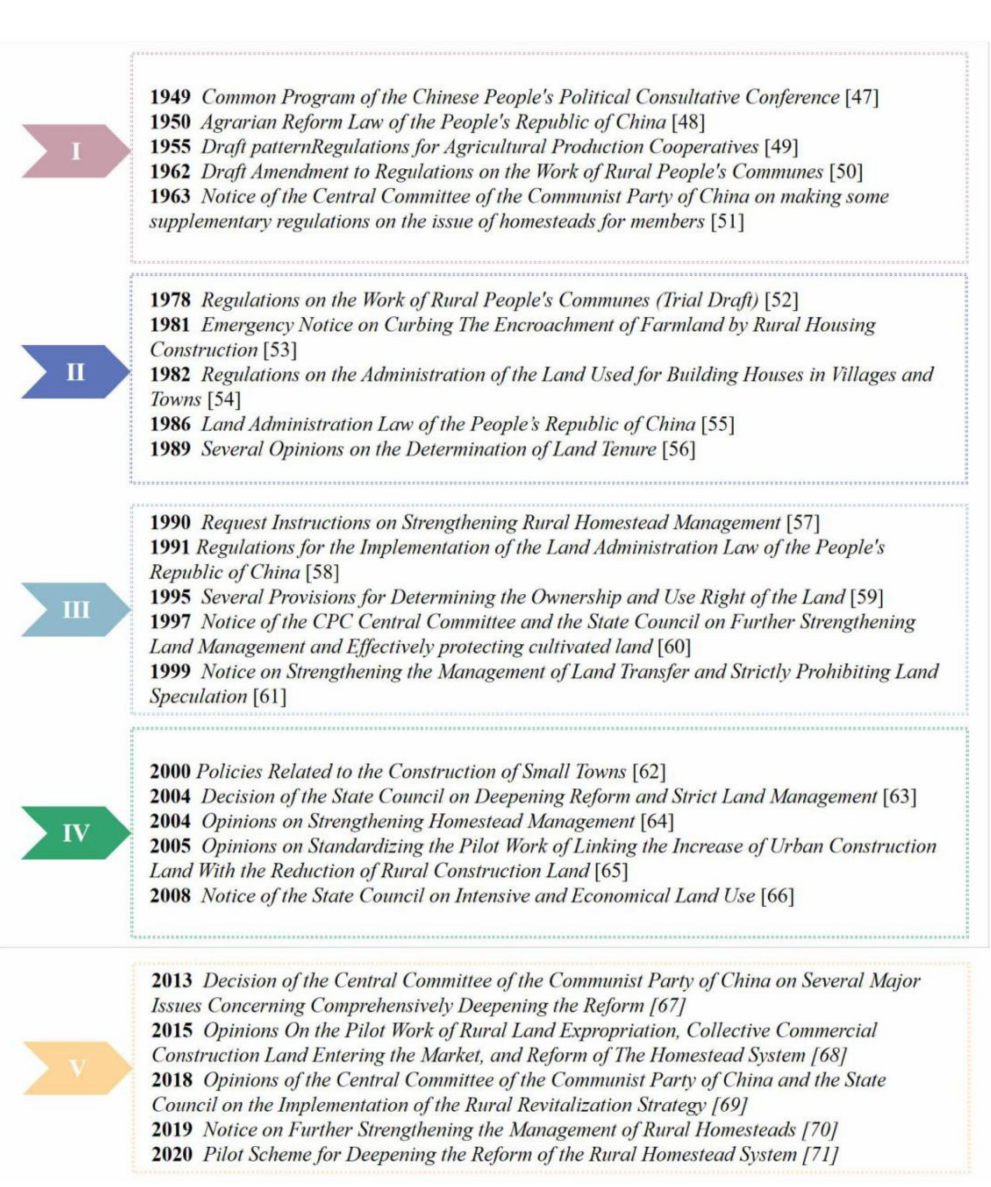
Figure 8. Partial Homestead Policy 1949–2020. Note: I: the period of transition from